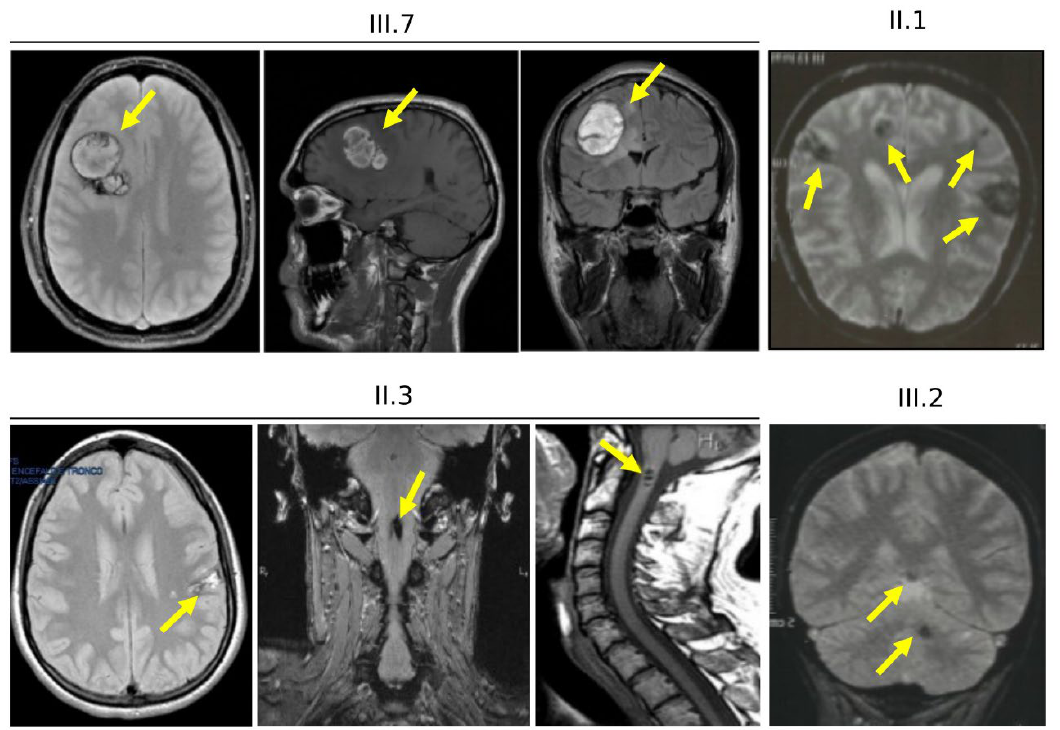
Figure 4. Brain and spinal cord magnetic resonance imaging of family 12. Representative brain and cervical spine MRI images of the proband ( III.7 ) and three affected family members ( II.1 , II.3 and III.2 ) obtained with a 1.5T MRI scanner. Arrows indicate CCM lesions (also see Figure 1B and Supplementary Figure S1).